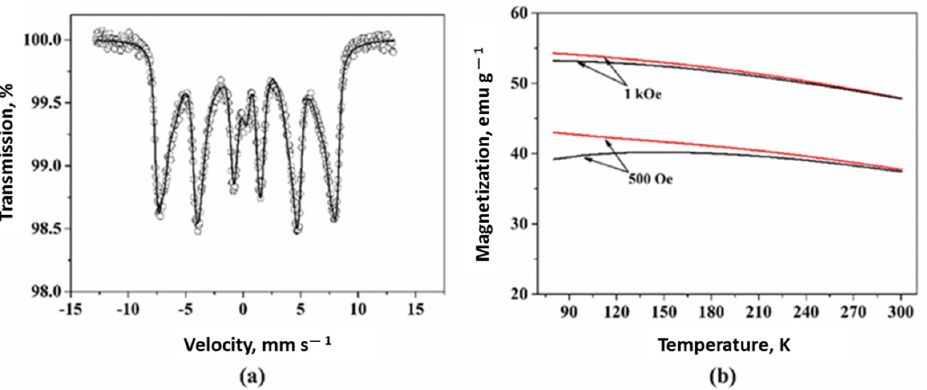
Figure 10. ( a ) Mössbauer spectroscopy and ( b ) FC/ZFC magnetization curves of as-prepared magnetite NPs in a powder form. Reprinted with permission [107], Copyright 2021, Elsevier.